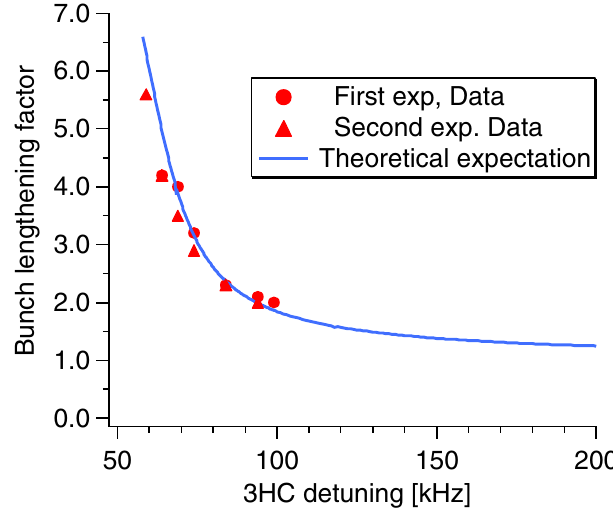
FIG. 10. (Color) rms bunch length along the bunch train for several 3HC tuning for a filling of 90%; I 2 : 0 GeV .